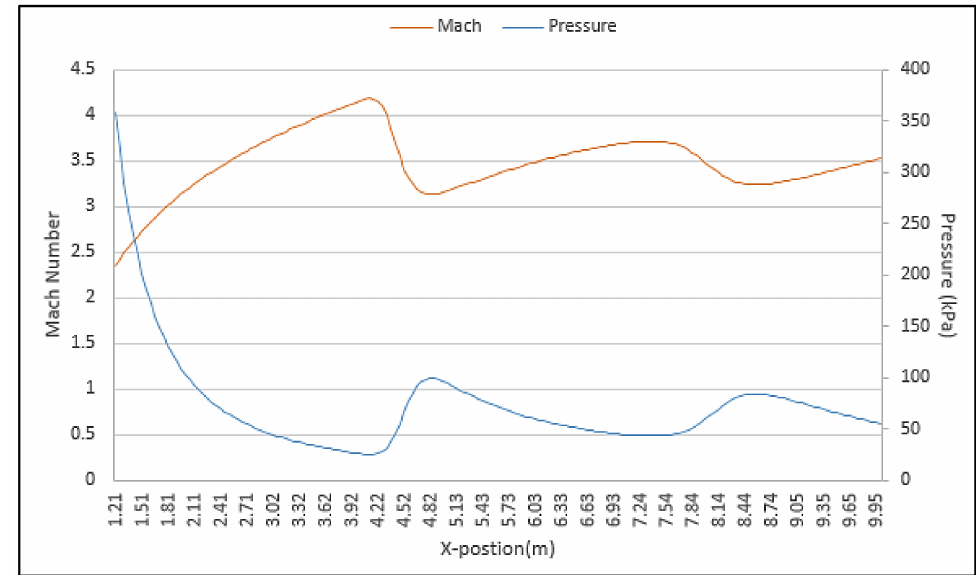
Figure 25. Pressure Mach plot across the base nozzle, extended nozzle, and beyond the exit.